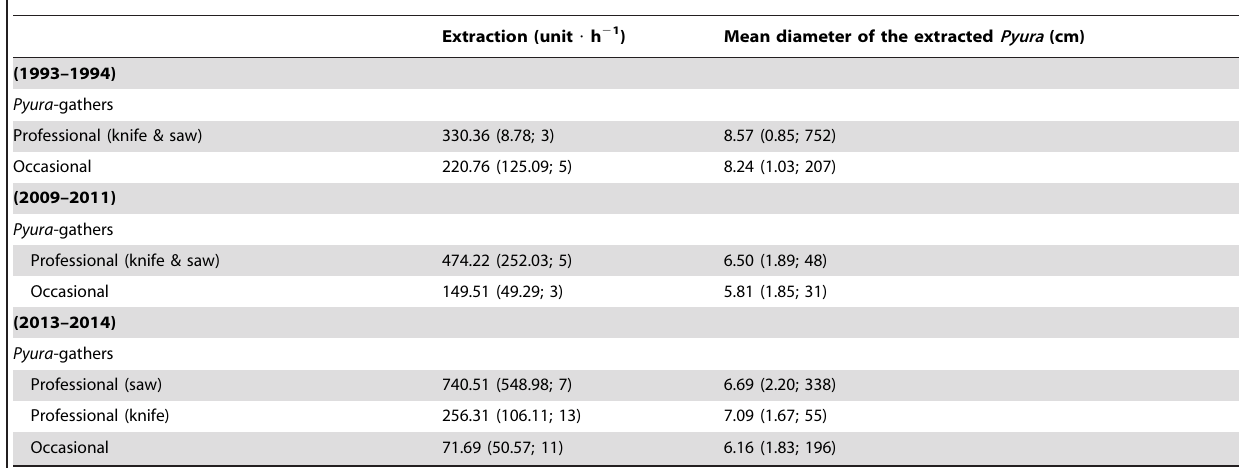
Table 2. Average ( 6 SD; N) descriptors of Pyura-gathers in Antofagasta Bay (C. Coloso, El Way, AAA, Trocadero, Fig. 1) divided into three temporal